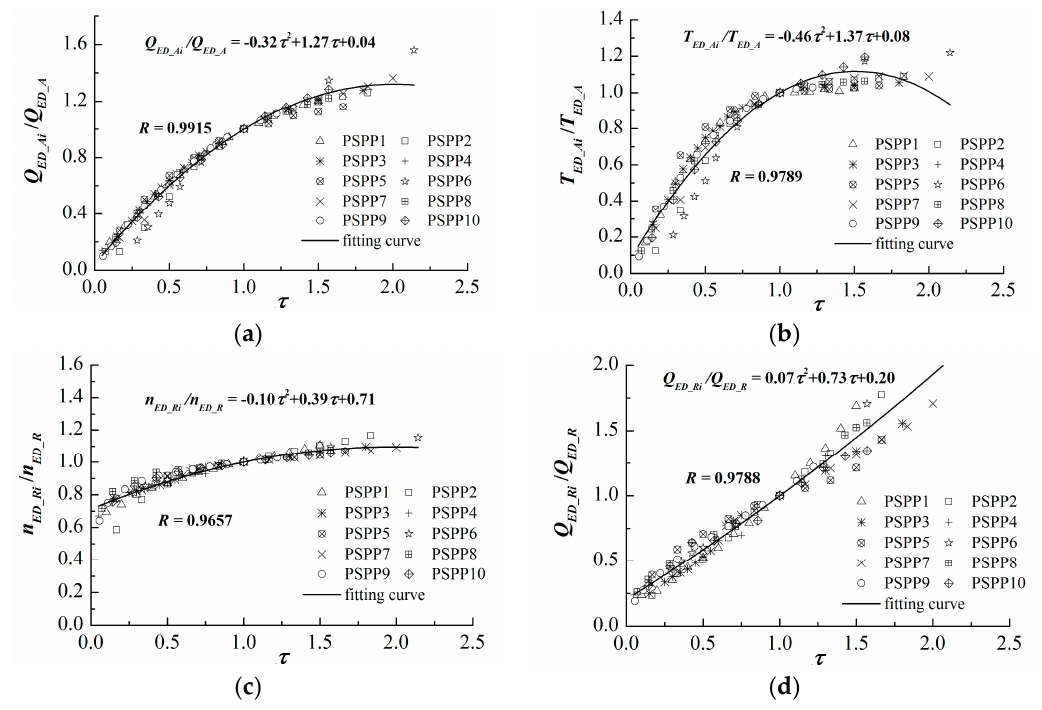
Figure 6. The relationship between τ and the relative characteristic parameters of A i and R i . ( a ) τ − Q ED _ Ai / Q ED _ A ; ( b ) τ − T ED _ Ai / T ED _ A ; ( c ) τ − n ED _ Ri / n ED _ R ; ( d ) τ − Q ED _ Ri / Q ED _ R